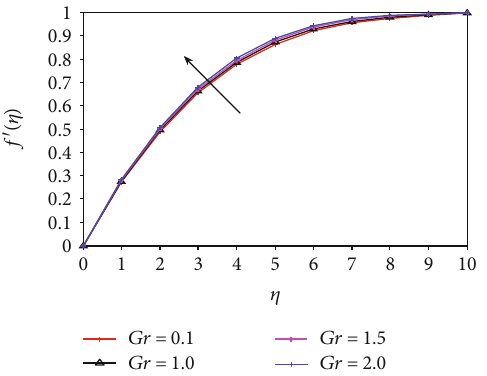
Figure 4: Velocity pro fi les for altered values of Gr once Pr = 0 : 72 , λ = M = Bi = Ra = 0 : 1 .